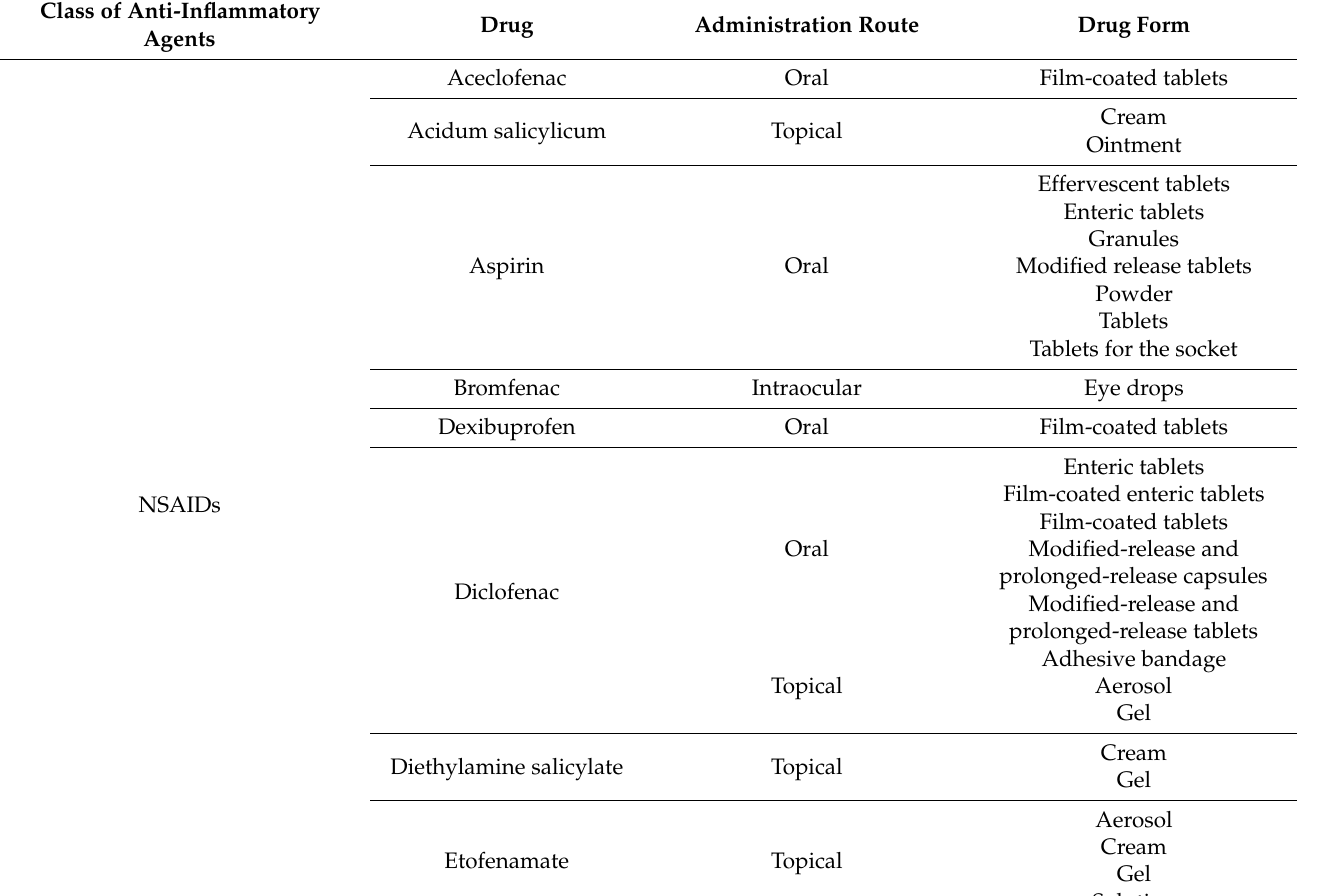
Table 2. The routes of administration of anti-inflammatory